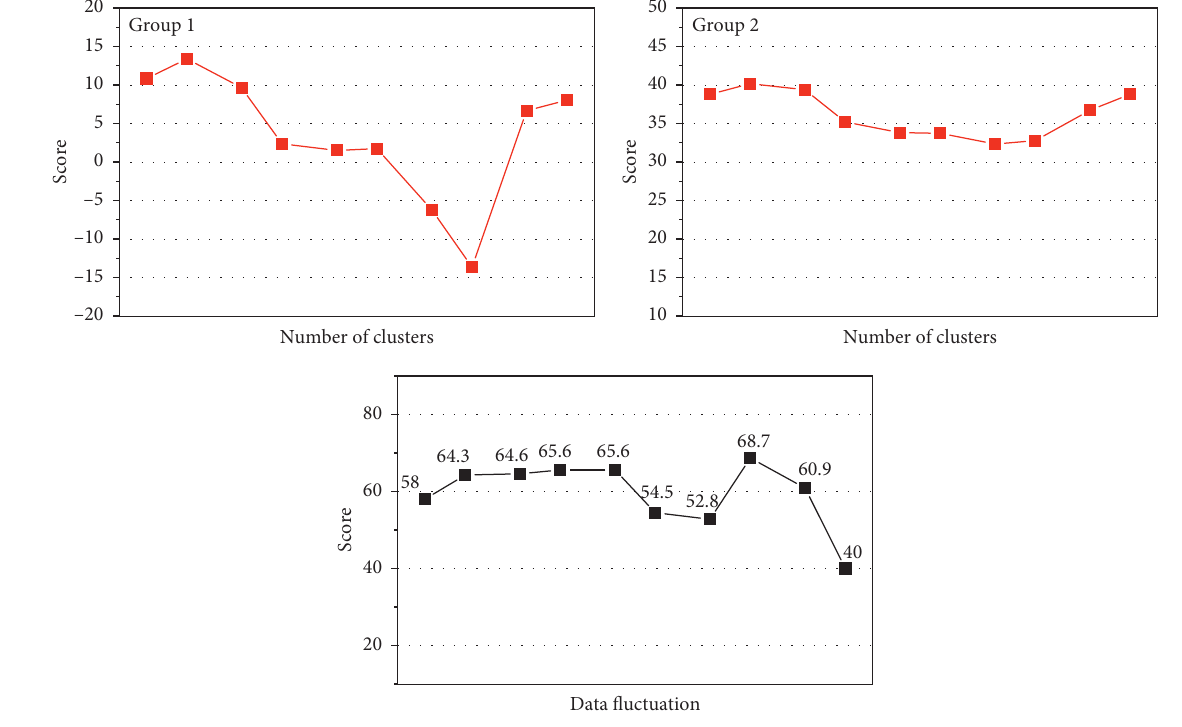
Figure 3: The SSE fold diagram.